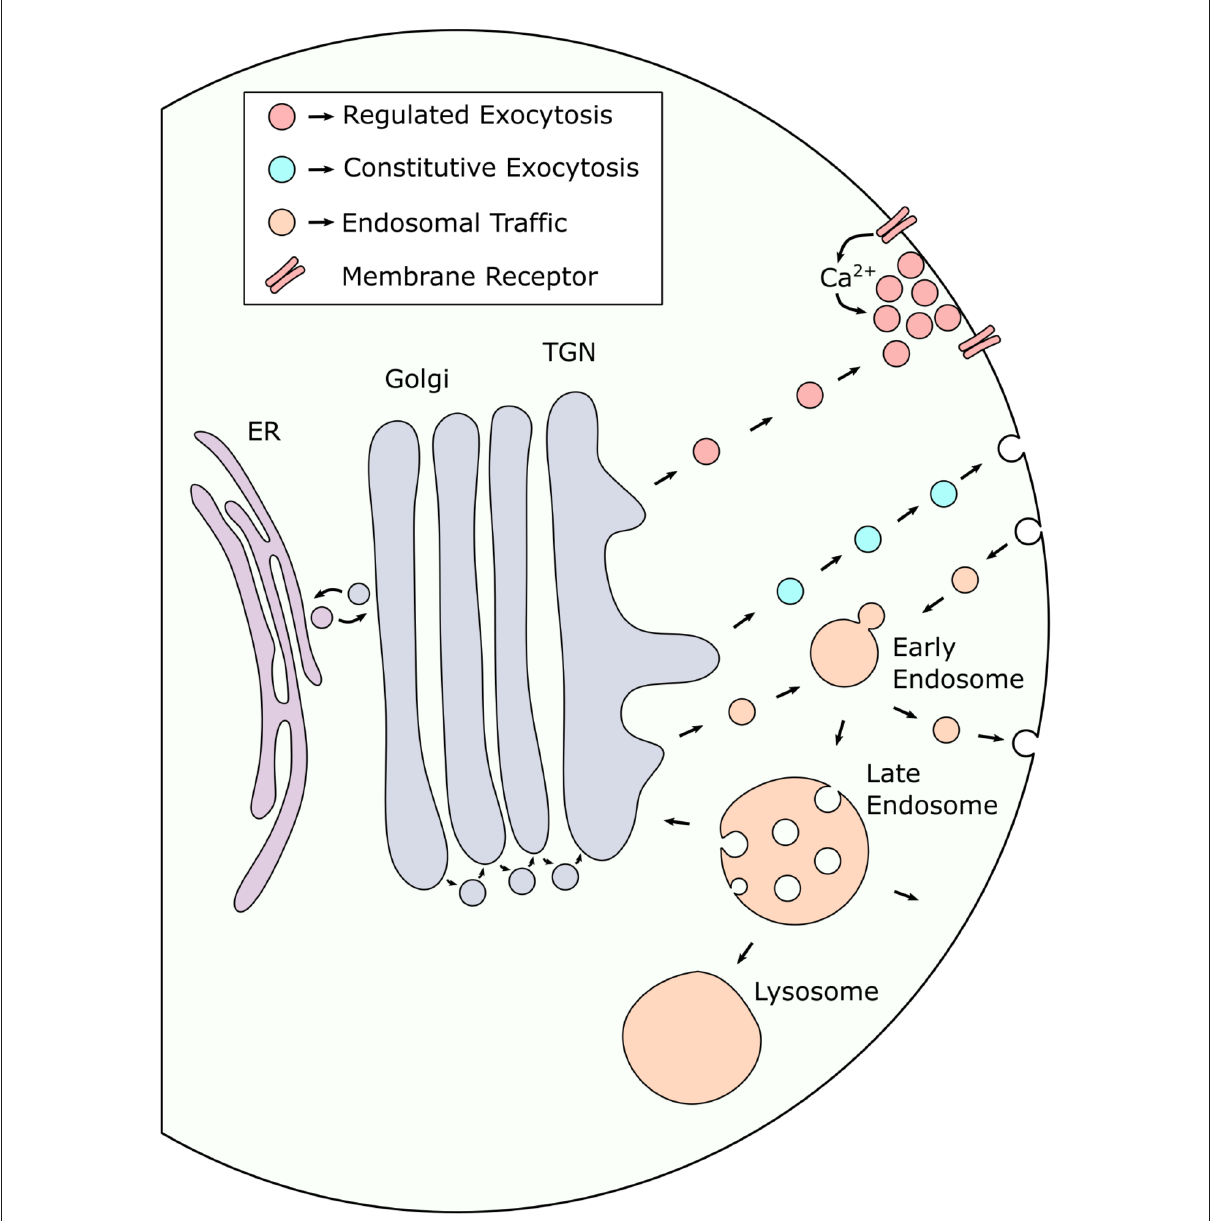
FIGURE2 Secreted proteins are trafficked to the cell surface via multiple distinct pathways. After synthesis in the endoplasmic reticulum (ER), proteins destined for exocytosis undergo processing in the Golgi before being sorted into intracellular transport vesicles in the trans-Golgi network (TGN). Transport vesicles leaving the TGN can either be targeted directly to the plasma membrane to undergo regulated or constitutive exocytosis or be transported to the endosomal pathway, either for further sorting prior to exocytosis or to deliver endosome specific cargo. Proteins that are retrieved from the cell surface are targeted to early endosomes (EE) which act as sorting platforms in endosomal traffic to and from the membrane. EEs can mature into late endosomes (LE) which act as a final sorting station for proteins destined for lysosomal degradation. LEs can also mature into multi-vesicular bodies (MVB) which can alternatively fuse with the plasma membrane to facilitate exosome release. Small arrowheads indicate the direction of vesicle